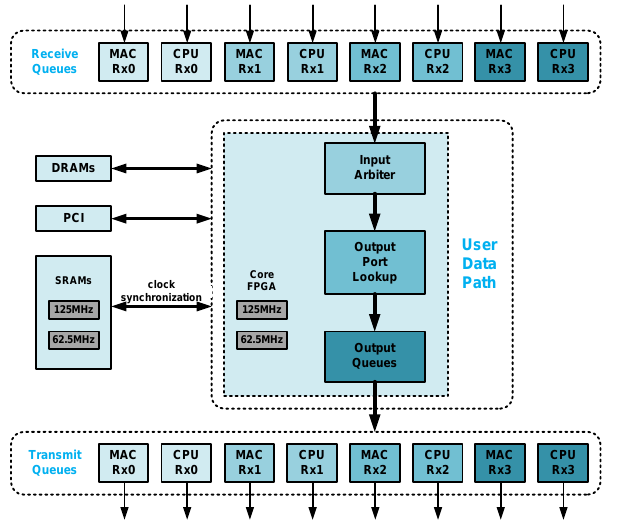
Figure 1. The architecture of the reference